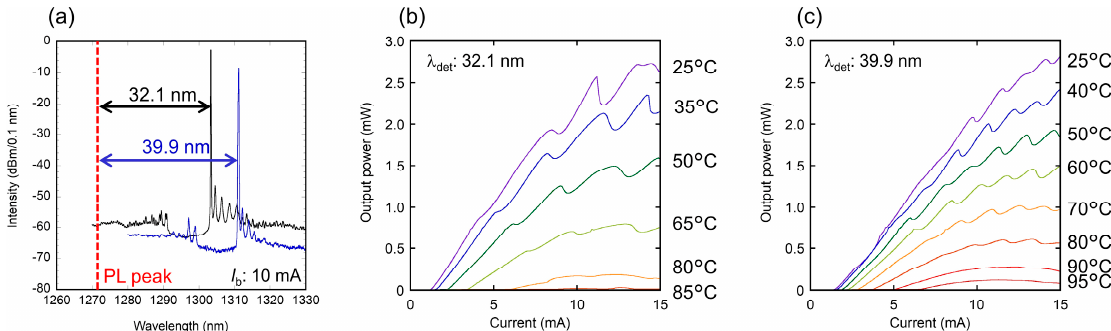
Figure 12. ( a ) Lasing spectra of two membrane lasers with different grating pitches; ( b , c ) temperature dependence of optical output vs. injection current for 32.1 ‐ and 39.9 ‐ nm ‐ detuned laser.